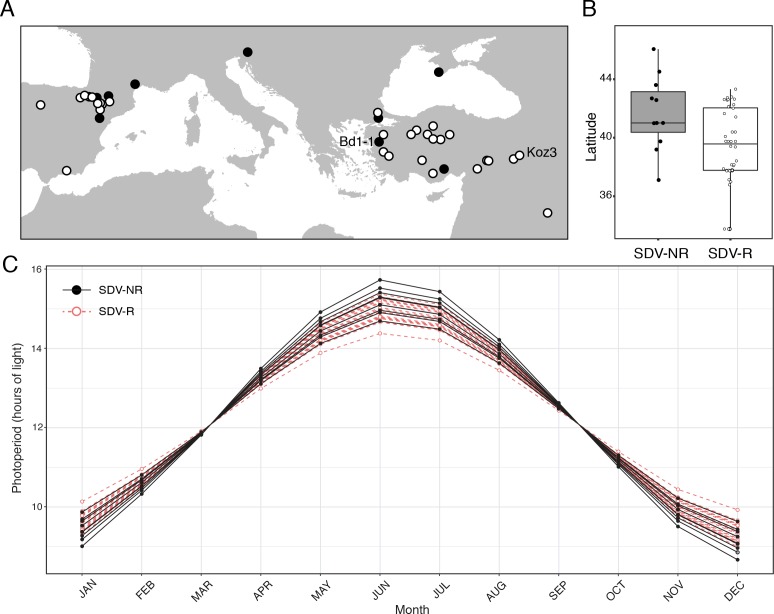
Geographical distribution of B.distachyon accessions used in this study.(A) Black dots represent SD vernalization-non-responsive accessions and white dots represent SD vernalization-responsive accessions. (B) Box plot indicating latitudinal distribution of SD vernalization non-responsive (SDV-NR; gray bar) and SD vernalization responsive (SDV-R; white bar) accessions. The difference is significant (p < 0.05). (C) Photoperiod throughout a year for each accession used in this study in their native habitat.